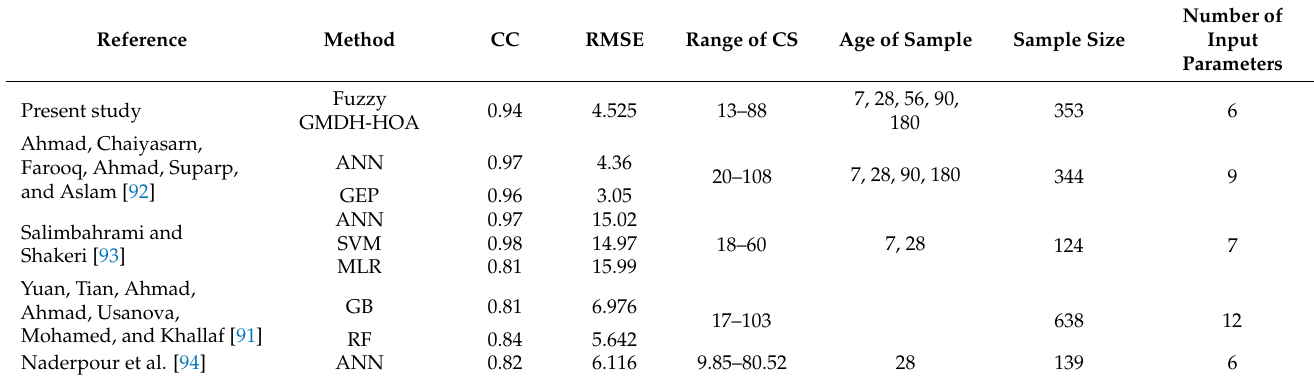
Table 6. Summary of the previous studies on prediction models of recycled concrete.